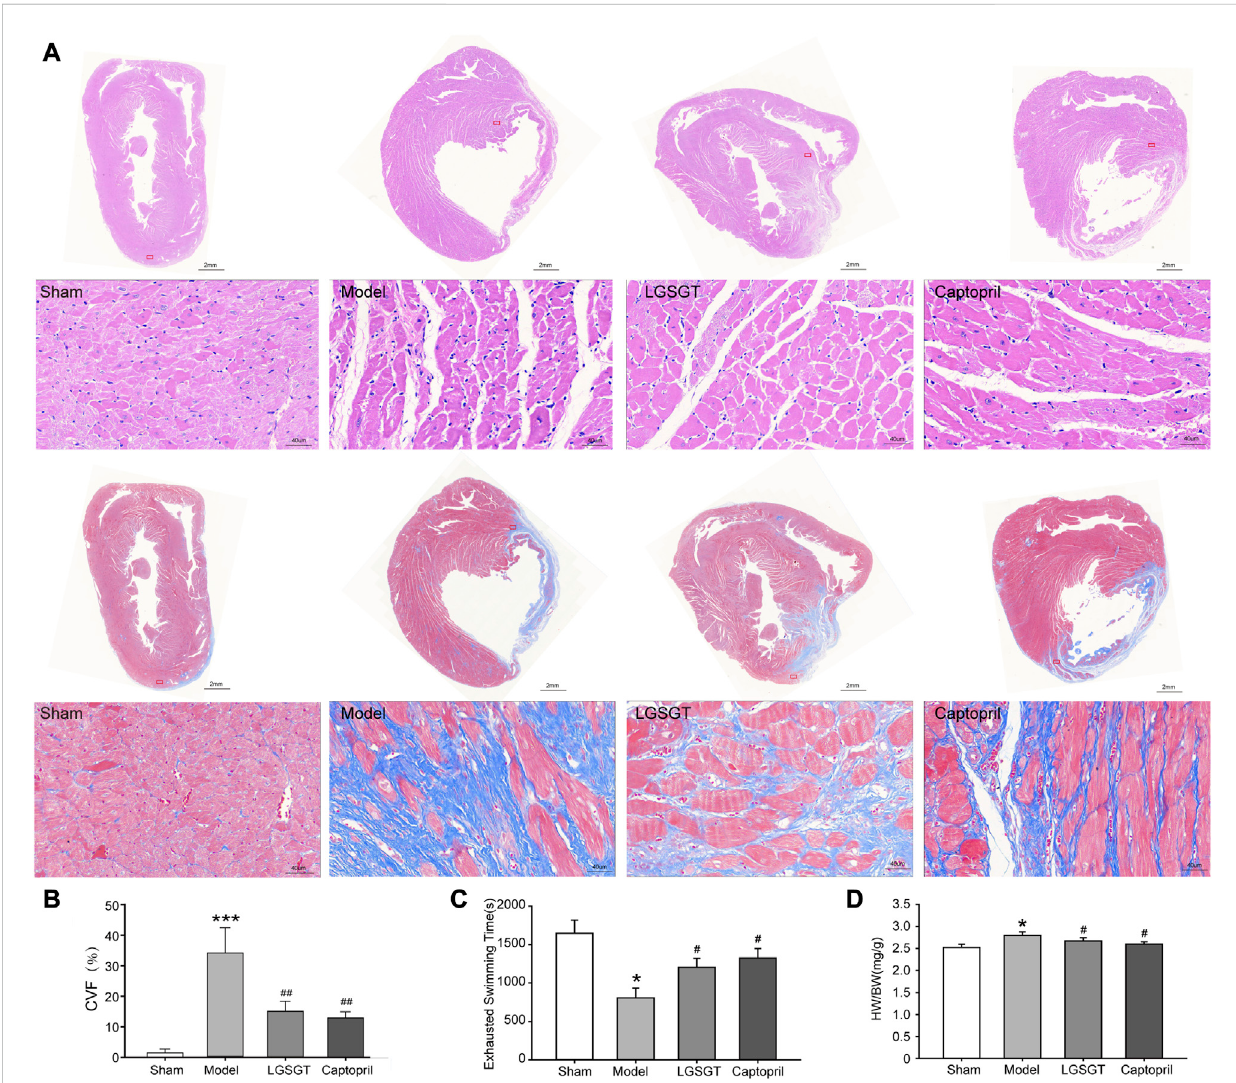
Linggui Zhugan Decoction protects the myocardium from myocardial injury and increases exercise tolerance in rats with chronic heart failure after myocardial infarction. (A) HE staining and Masson staining of myocardial tissue in each group. (B) The collagen volume fraction in each group ( n = 6). (C) Exhaustiveswimmingmethodtoevaluateexercisetoleranceinratswithheartfailure( n =8). (D) Theheartweightindexineachgroup(heartweight/body weight). Asterisks indicate signi fi cant difference as compared with the sham group ( n = 8). * p < 0.05 vs. sham group; # p < 0.05 vs. model